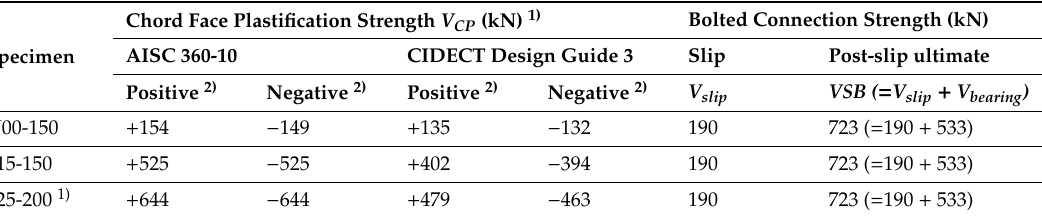
Table 5. Theoretical strengths of plate-to-RHS truss